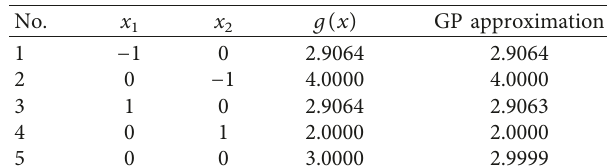
Table 1: Training samples and the predicted values using GP for Example 1.